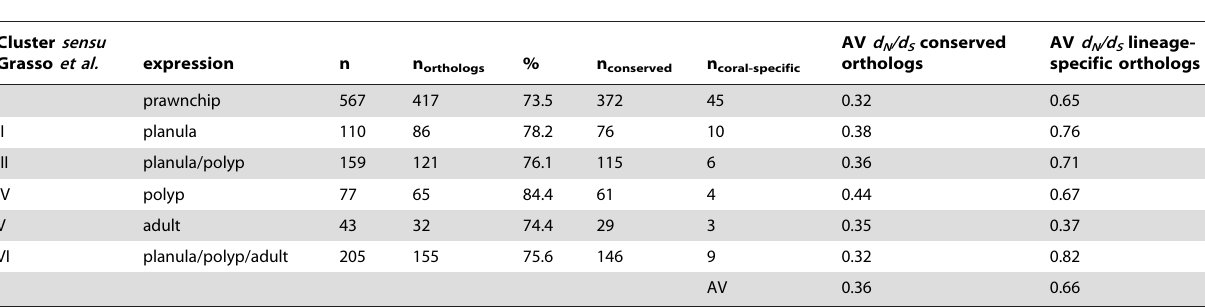
Table 2. Expression of d N /d S orthologs across developmental stages of Acropora millepora .